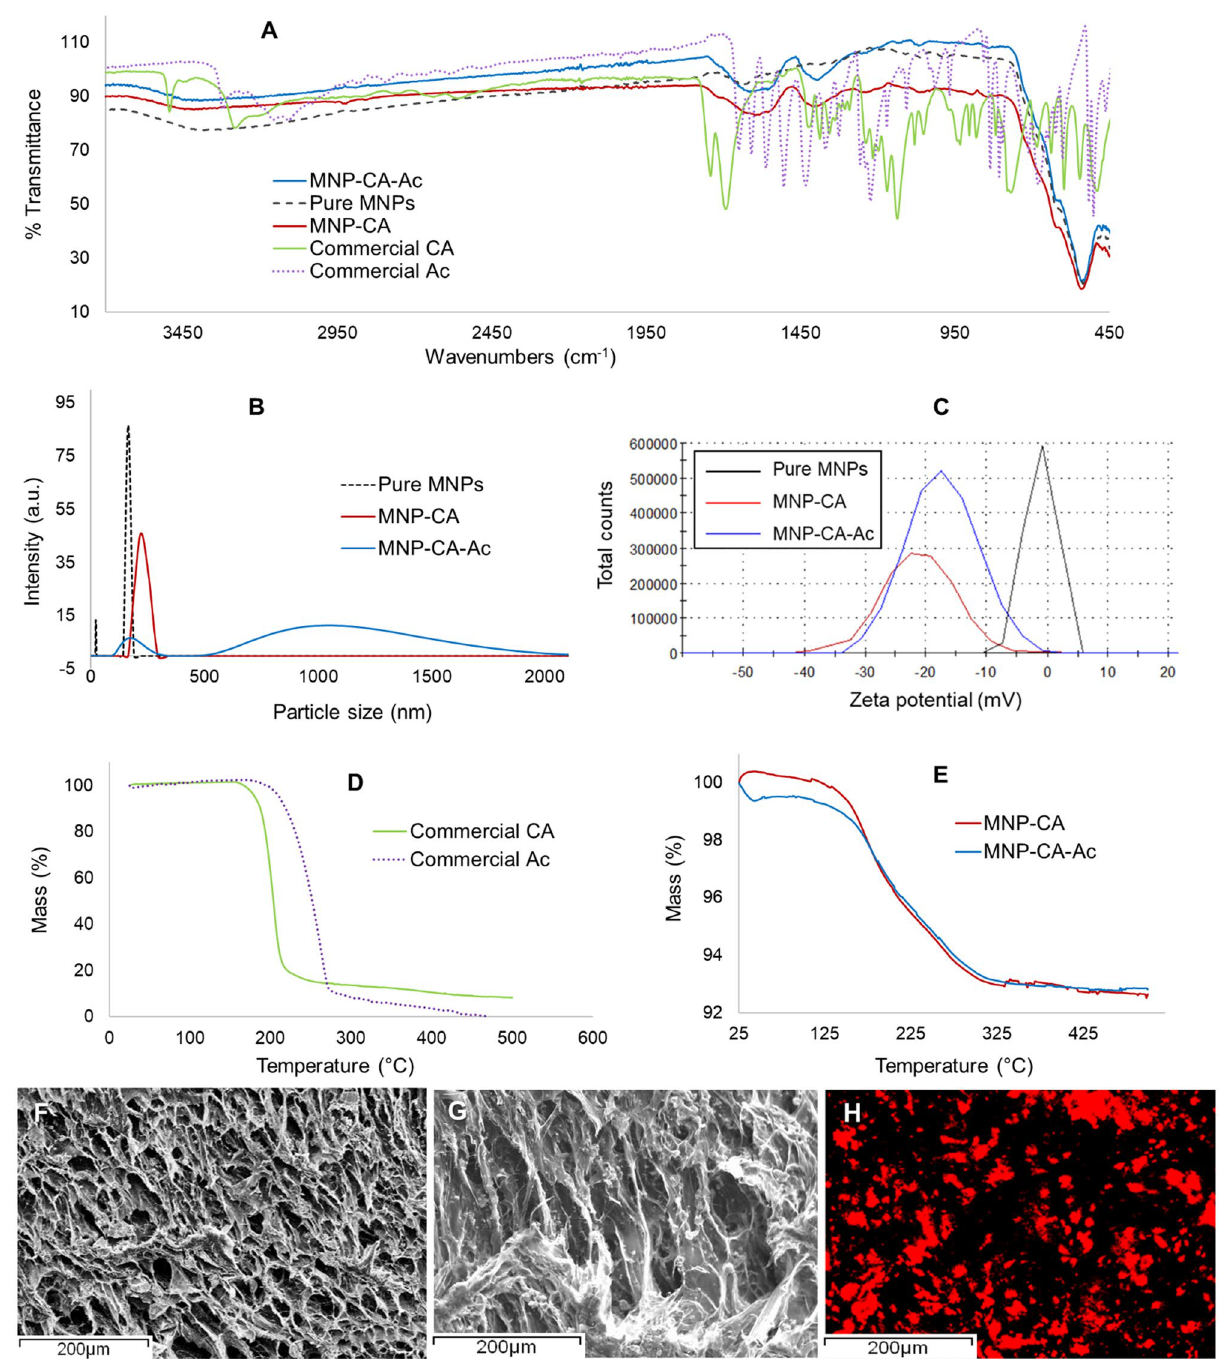
Figure 2. Characterization of PVA-MNP hydrogels. ( A ) FTIR spectra of all samples. ( B ) DLS data for pure MNPs, MNP-CA and MNP-CA-Ac samples indicating differences in particles sizes. ( C ) Zeta potential data for pure MNPs, MNP-CA and MNP-CA-Ac samples indicating differences in surface charges. ( D ) TGA data for commercial citric and acetaminophen. ( E ) TGA data for MNP-CA and MNP-CA-Ac samples. ( F , G ) SEM images of freeze-dried drug coated PVA-MNP hydrogels. ( H ) EDX data for SEM image G, where drug coated MNP distribution is depicted in red, indicating a homogeneous distribution of the MNP-CA-Ac system within the